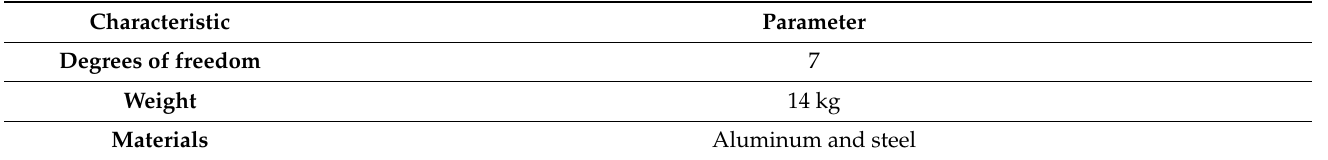
Table 10. Characteristics of the ERMIS